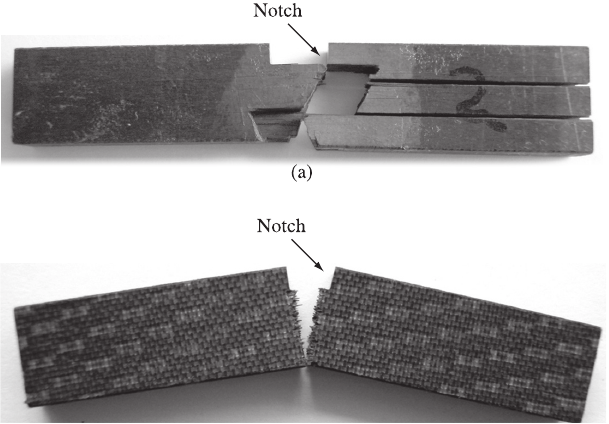
Figure 7. Impacted C-Ep laminates tested under identical conditions and exhibiting entirely different fracture patterns: a) TP120 and b) TC120.